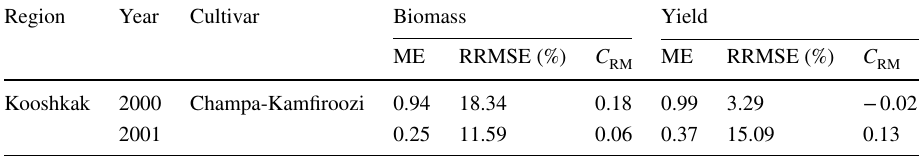
Table 7 Amounts of ME, RRMSE and C RM for yield simulation in Rasht